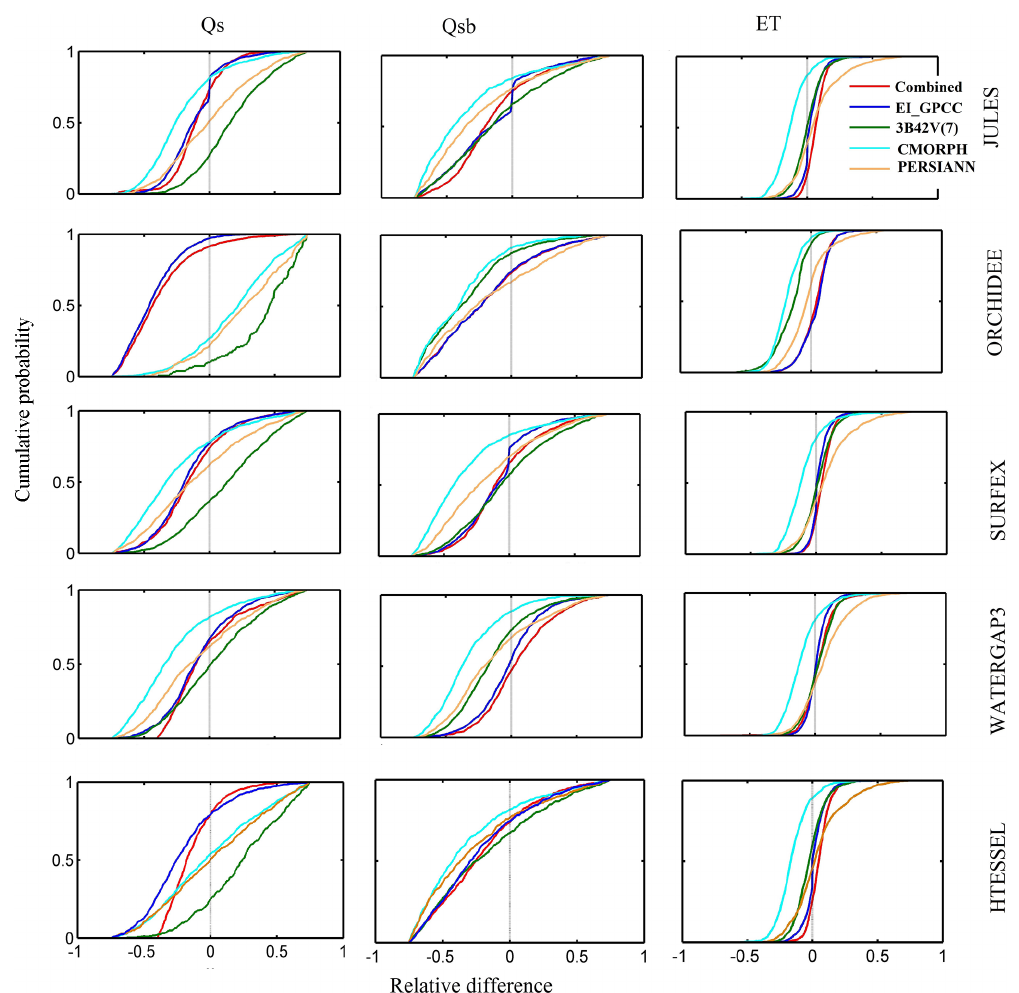
Figure 7. Cumulative probability for the multi-model, multi-forcing simulations for simulated hydrological